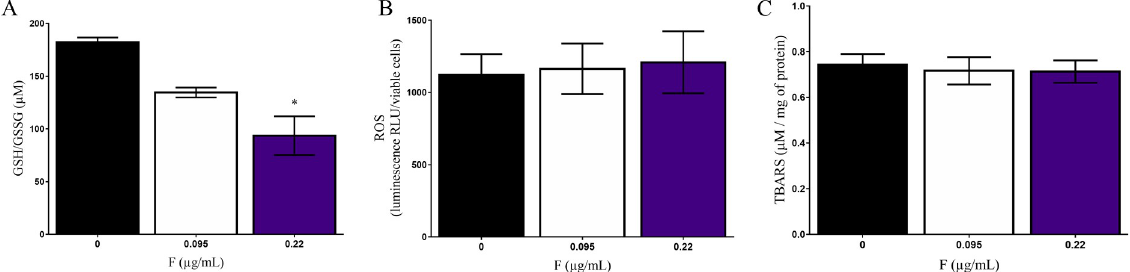
Fig 6. Oxidative stress parameters of fluoride exposure on U87 cells. A) GSH/GSSG ratio, B) Reactive oxygen species (ROS) and B) Lipid peroxidation (TBARS) were evaluated after 10 days of 0.095 and 0.22 μ g/mL F expo-sure. Data were expressed as mean ± SD. Statistical analysis were performed by one-way ANOVA followed by Tukey. Statistical significance compared to control group was showed by � whenever p < 0.05.